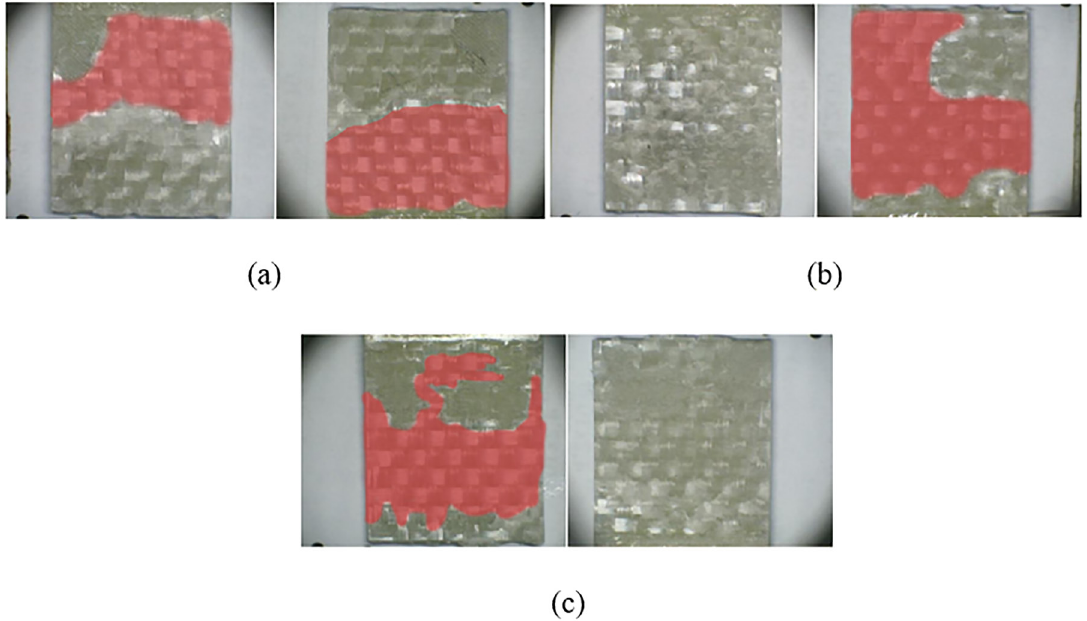
Figure 7. Failure modes for pure adhesive. (a) Group A00-005; (b) Group A00-015; (c) Group A00-040. Areas in red indicating the LFT failures.